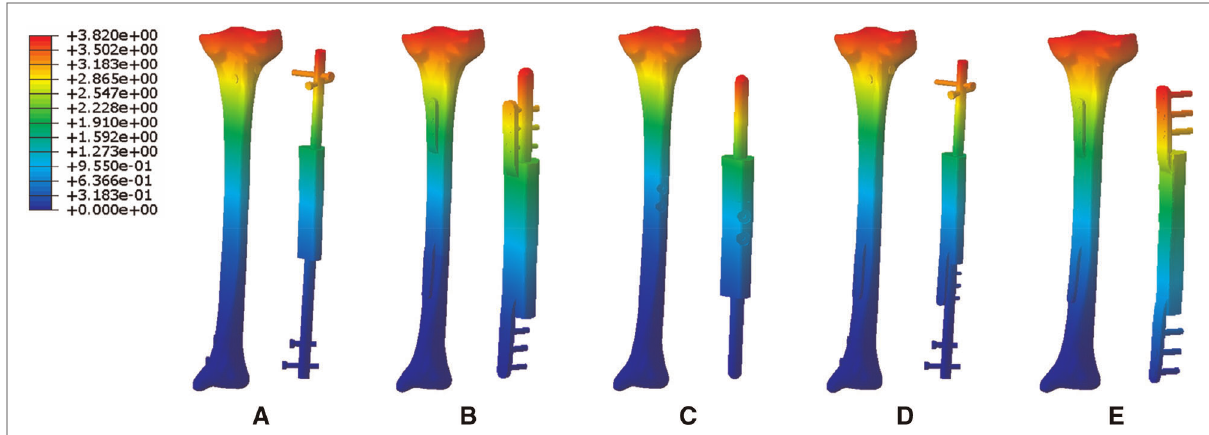
FIGURE 10 The deformation displacement characteristics of fi ve modes ( A : Mode I; B : Mode II; C : Mode III; D : Mode IV; E : Mode V).